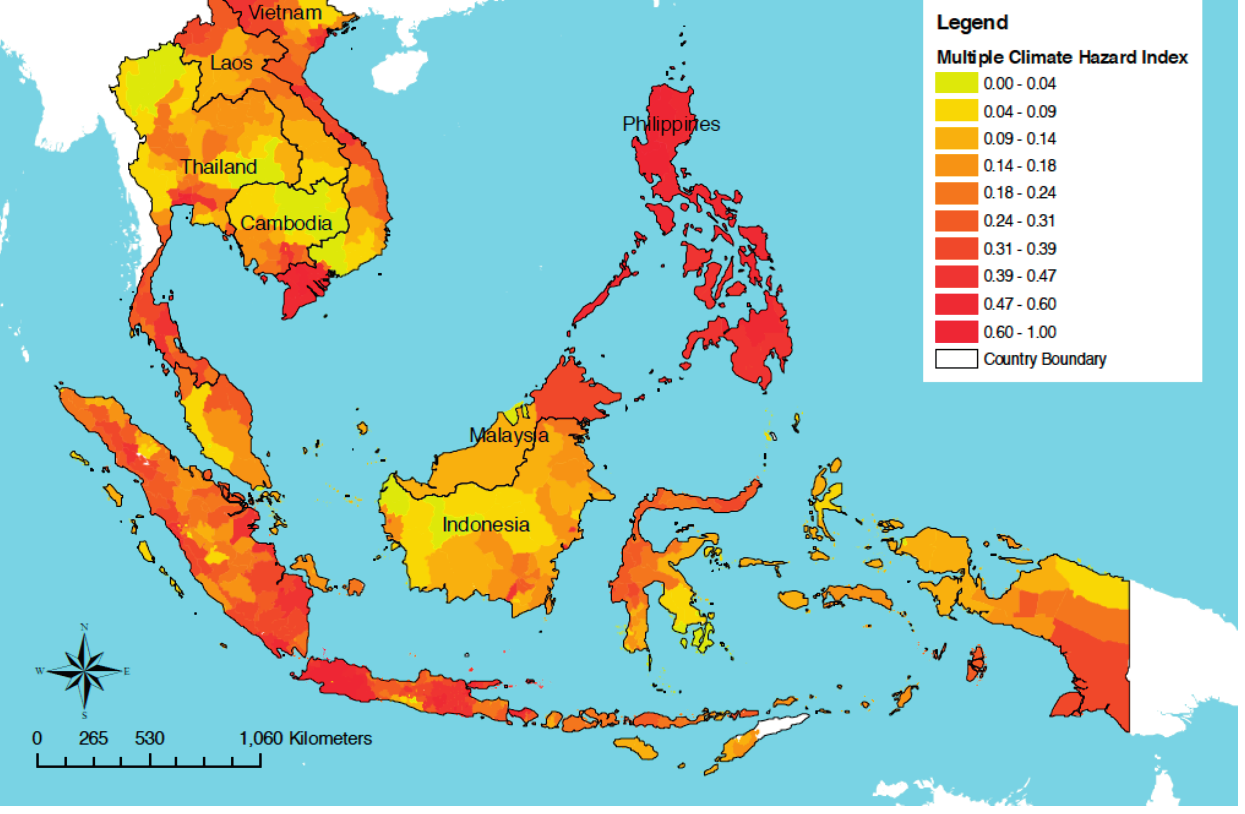
Figure 1. Map of vulnerability to climate change in Southeast Asia, taking into account exposure to climate hazards (tropical cyclones, floods, landslides, droughts and sea level rise), sensitivity and adaptive capacity. 0 indicates lowest vulnerability, 1 indicates highest vulnerability. Source: Reproduced with permission from Yusuf and Franciso